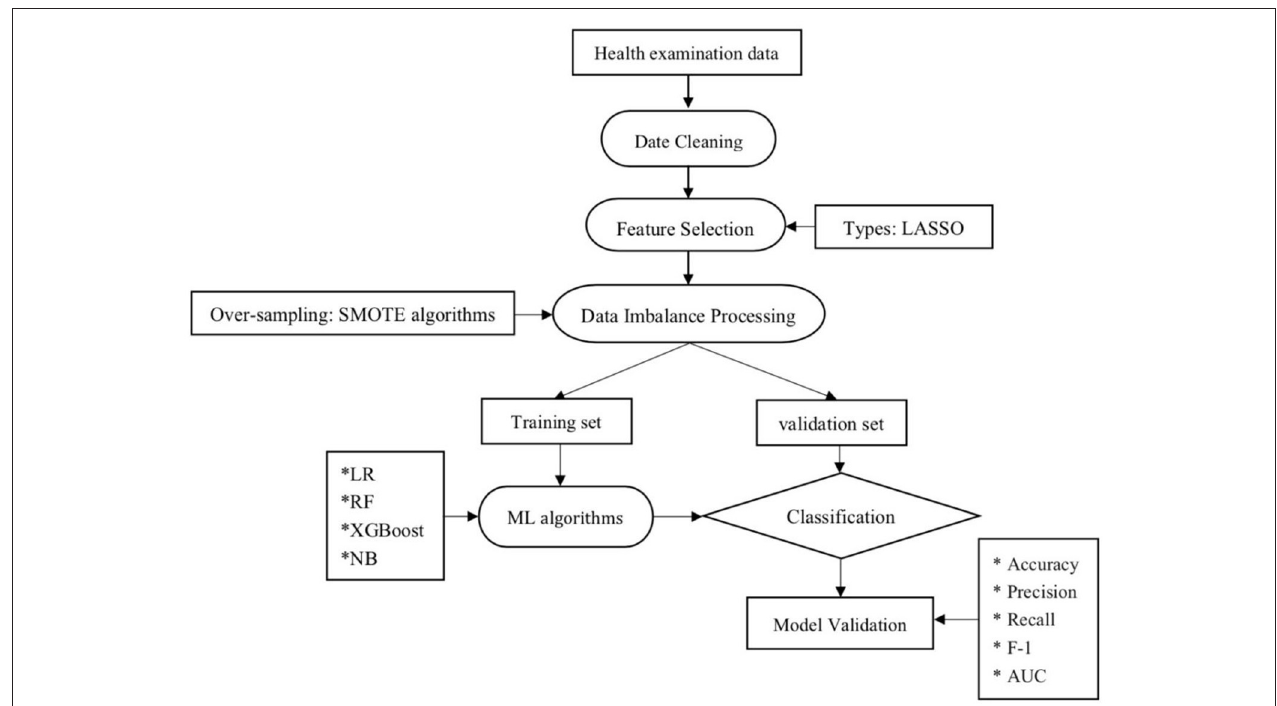
FIGURE 1 | Machine learning flowchart of this study. LR, logistic regression; RF, random forest; NB, Naive Bayesian; ML, machine learning; LASSO, least absolute shrinkage and selection